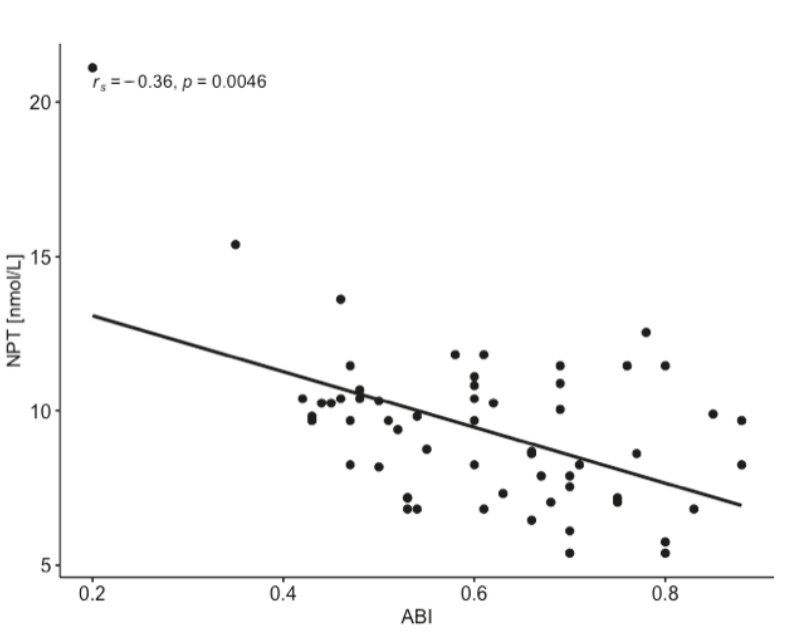
Figure 3. Relationship between ankle-brachial index (ABI) and neopterin (NPT) in patients with peripheral artery disease ( n =